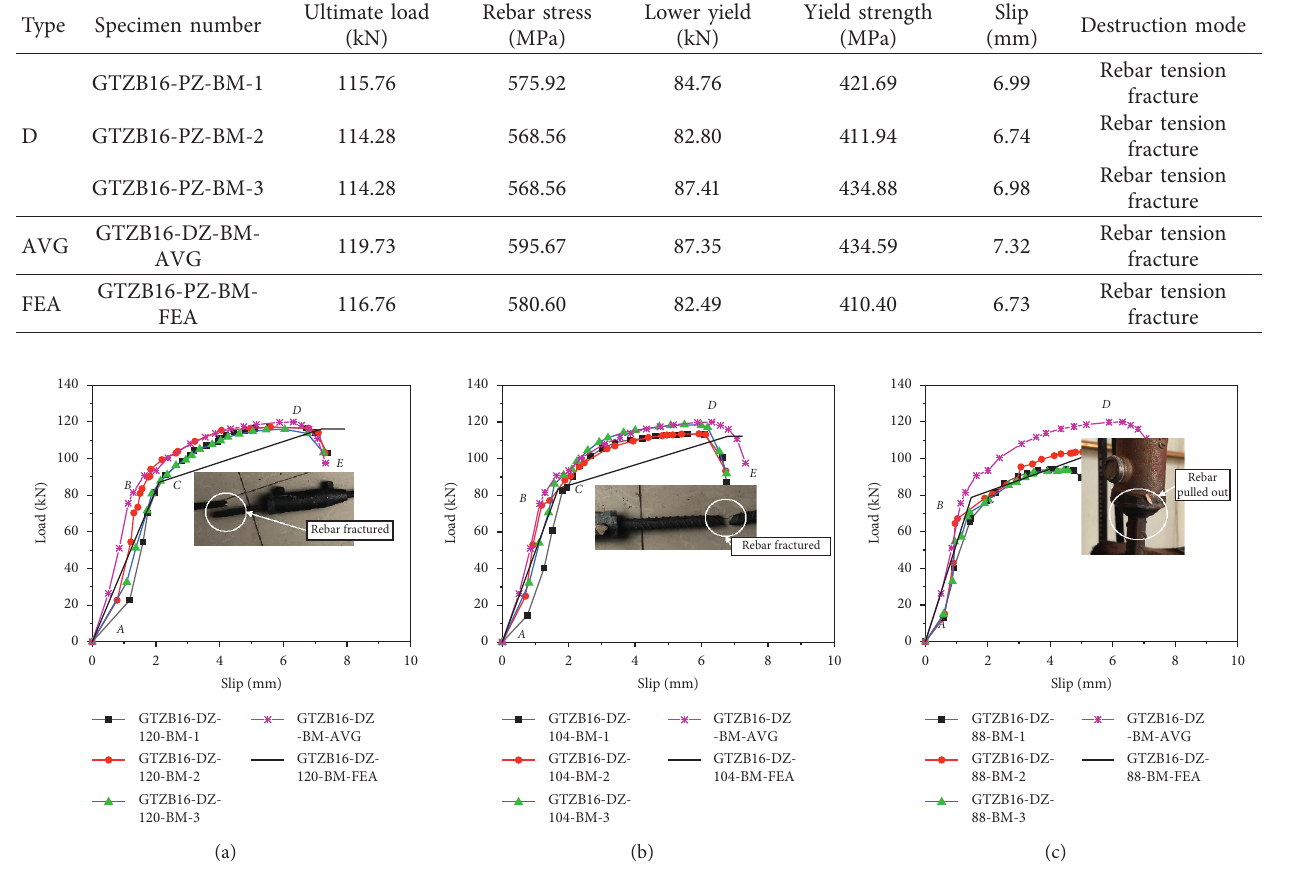
Figure 16: The load-slip curves of the insufficient rebar anchor length specimen (AVG: average value; FEA: finite element analysis). Rebar anchor: (a) 120mm (7.5d); (b) 104mm (6.5d); (c) 88mm